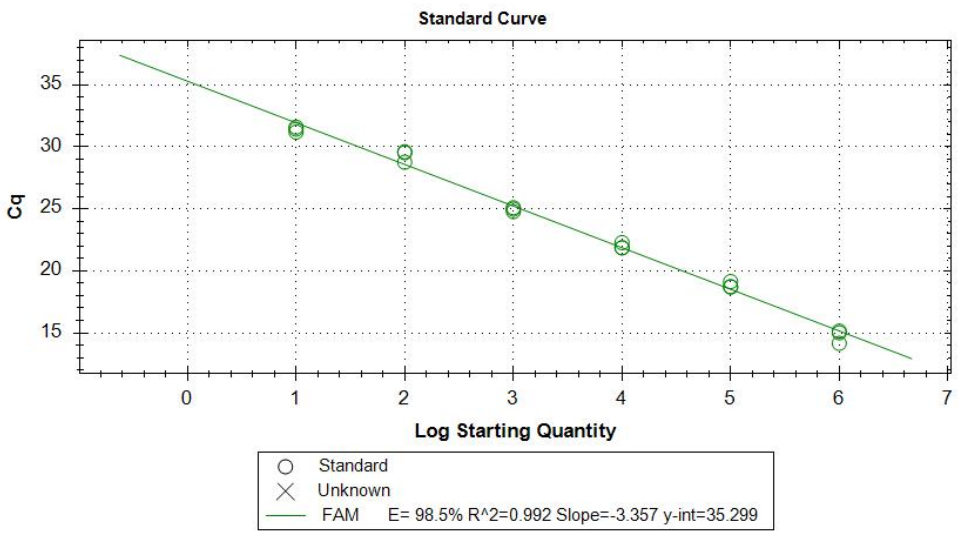
Figure 1. Standard curve for TaqMan-qPCR from known cultured promastigote concentrations.